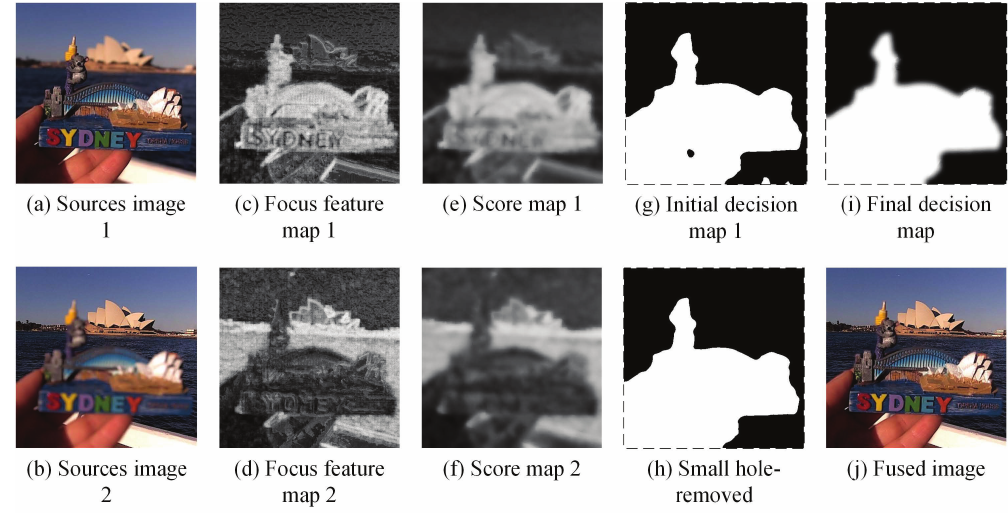
Figure 7. Obtaining the decision map and multi-focus image